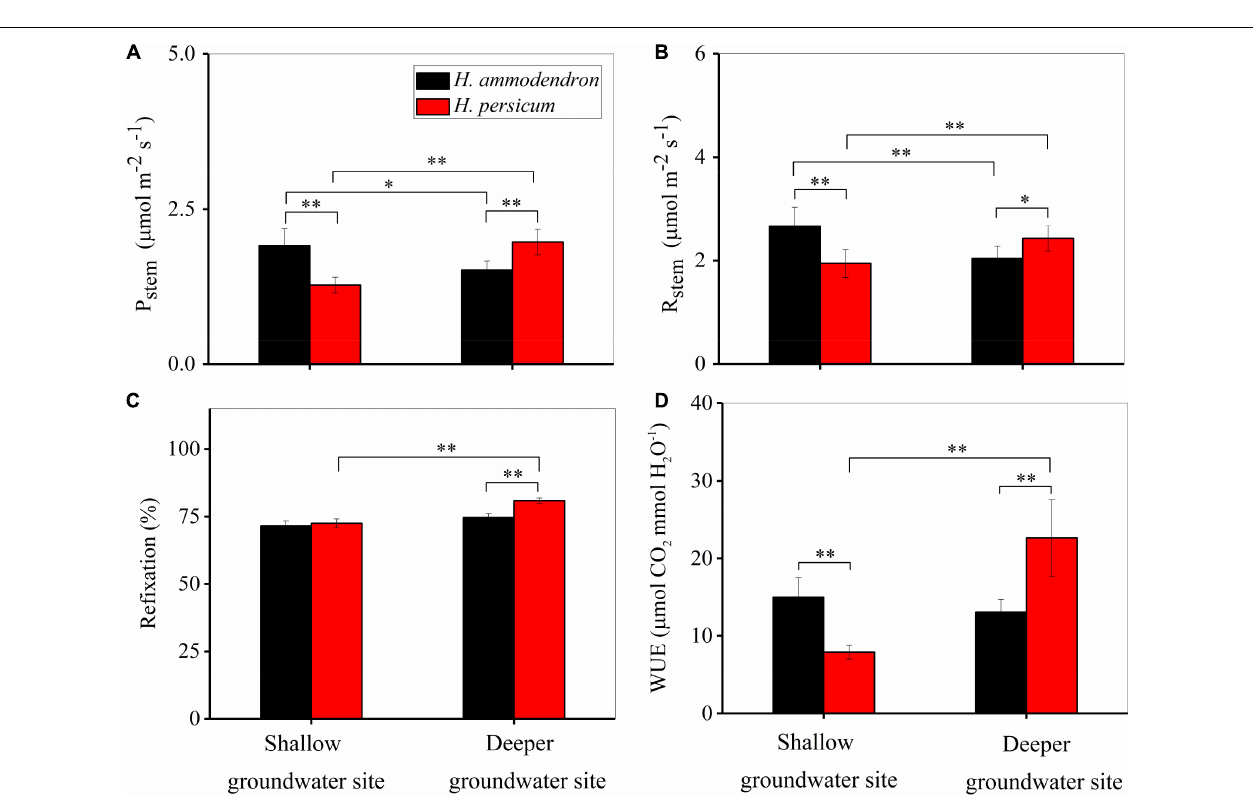
FIGURE 5 | Average daily patterns of the stem ( P stem ) (A,B) photosynthesis for two Haloxylon species at two sites. Error bars represent SE ( n = 3).